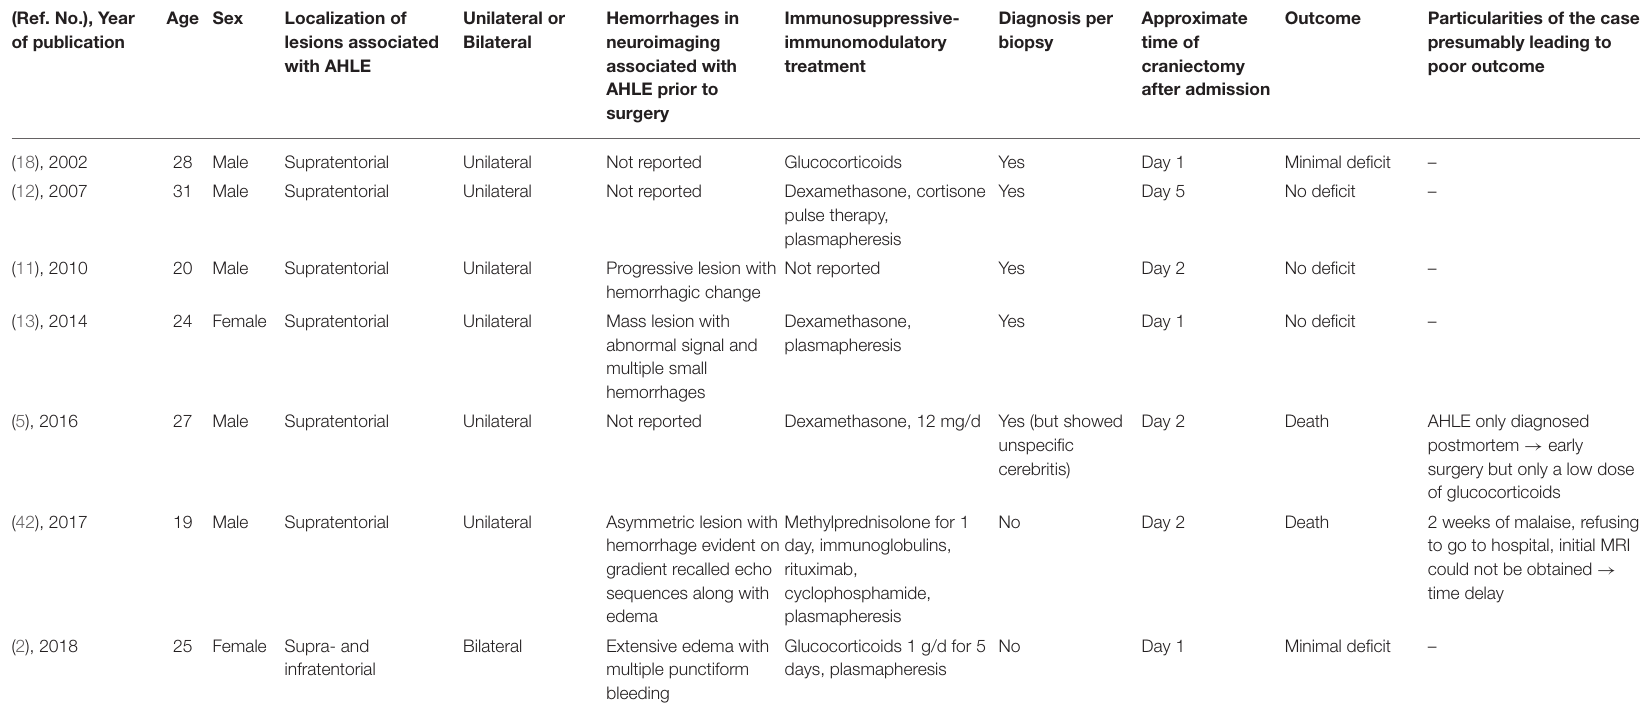
TABLE 2 | Clinical, neuroradiologic, and neuropathologic characteristics of adult patients who received craniectomy with AHLE. (Ref. No.), Year of